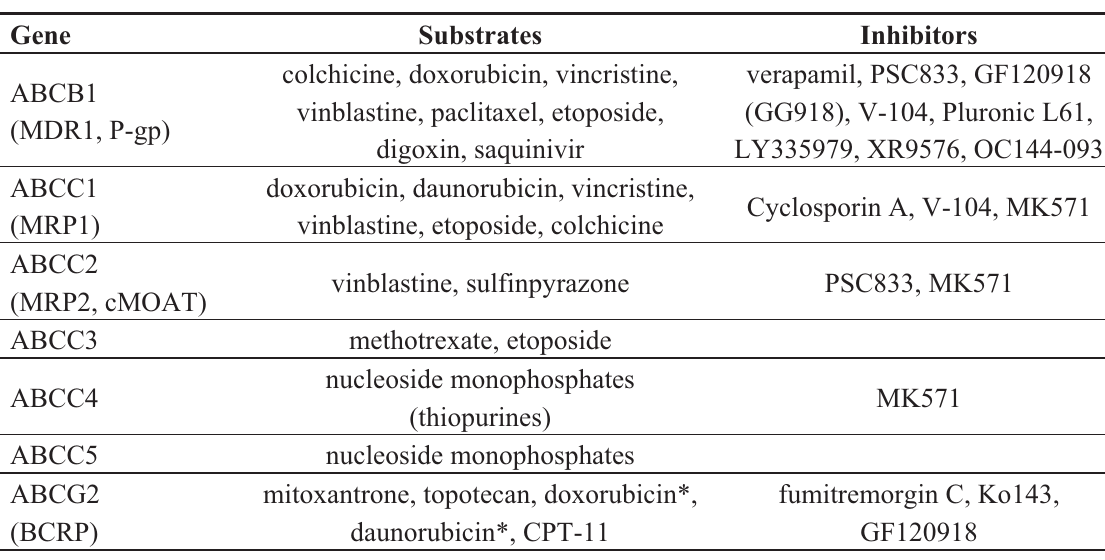
Figure 2. Overlap in cytotoxic dugs as substrates for the major ABC-transporters ABCB1 (P-gp), ABCC1 (MRP1) and ABCG2 (BCRP). Table 3. Overview of the relevant ABC transporters associated with drug resistance to cytotoxic agents in humans (adapted from Dean M. The Human ATP-Binding Cassette (ABC) Transporter Superfamily [Internet]. Bethesda (MD): National Center for Biotechnology Information (US); 2002 Nov